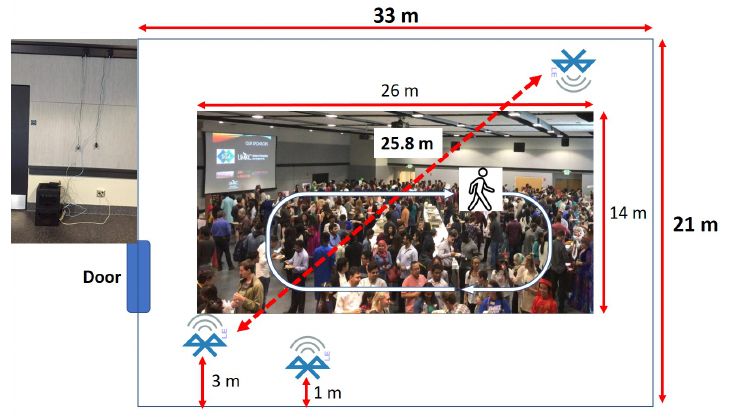
Figure 12. Culture night indoor experiment.